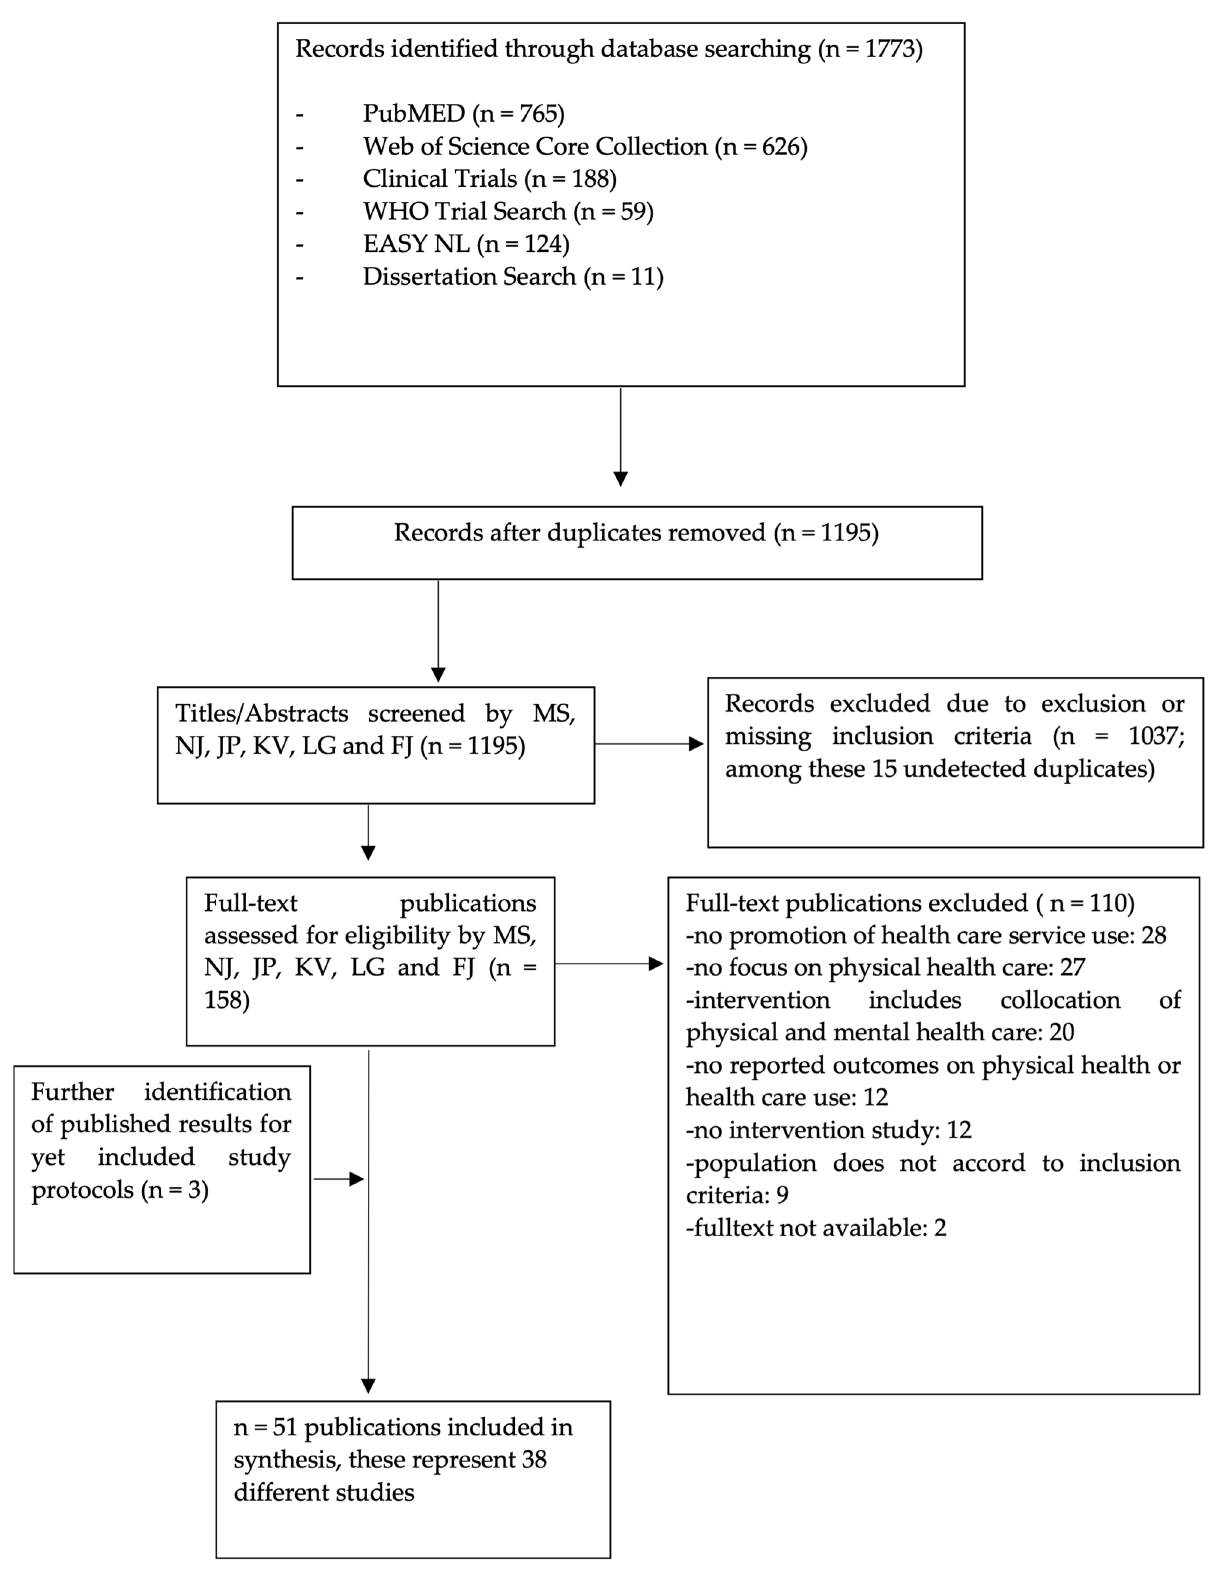
Figure 1. Study selection and the exclusion process (PRISMA flow diagram).